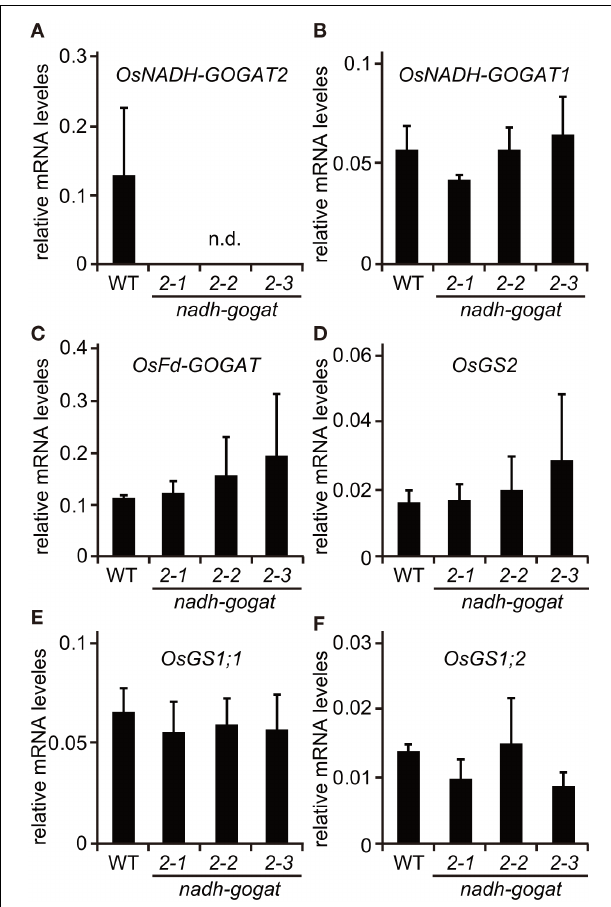
FIGURE 2 | Real-time PCR detection of mRNAs for OsNADH-GOGAT 2 (A) , OsNADH-GOGAT 1 (B), OsFd-GOGAT (C), OsGS 2 (D), OsGS 1 ; 1 (E), and OsGS 1 ; 2 (F) from a flag leaf of wild-type (WT) and Tos 17-inserted homozygous lines grown with soil in a green house. Three knockout lines, ND2034, NC0418, and NG3002, were indicated as in nadh-gogat 2 - 1 , 2 - 2 , and 2 - 3 in this figure, respectively. mRNA contents were normalized using actin mRNA. Means of independent triplicate samples and SD are